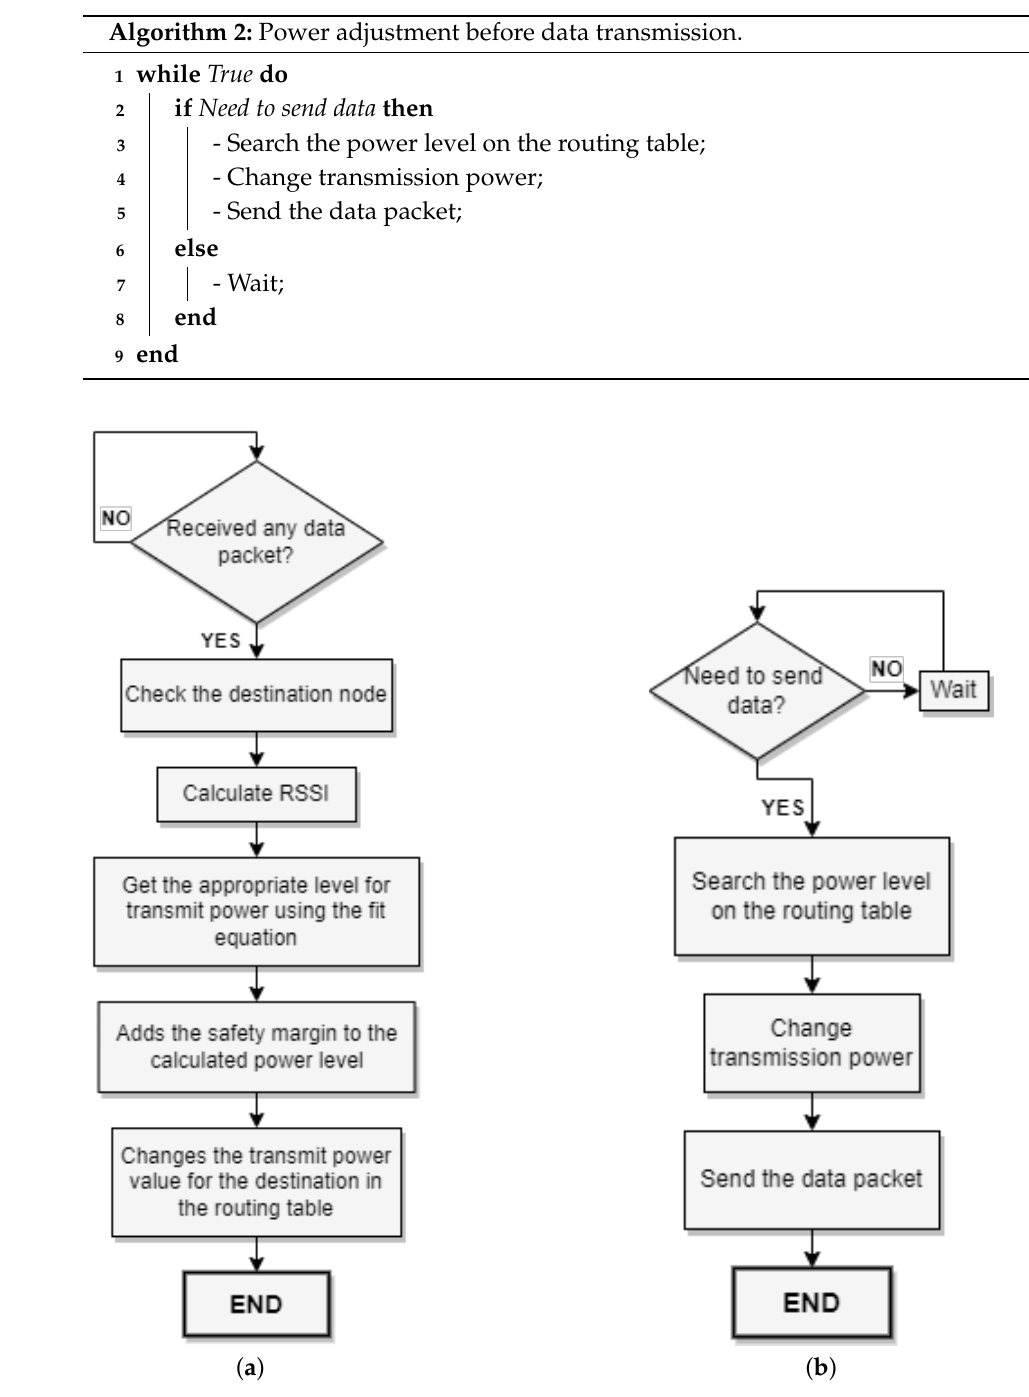
Figure 2. P TX Adjustment Flowcharts: ( a ) identification of the P TX level of a destination node and ( b ) power adjustment before data